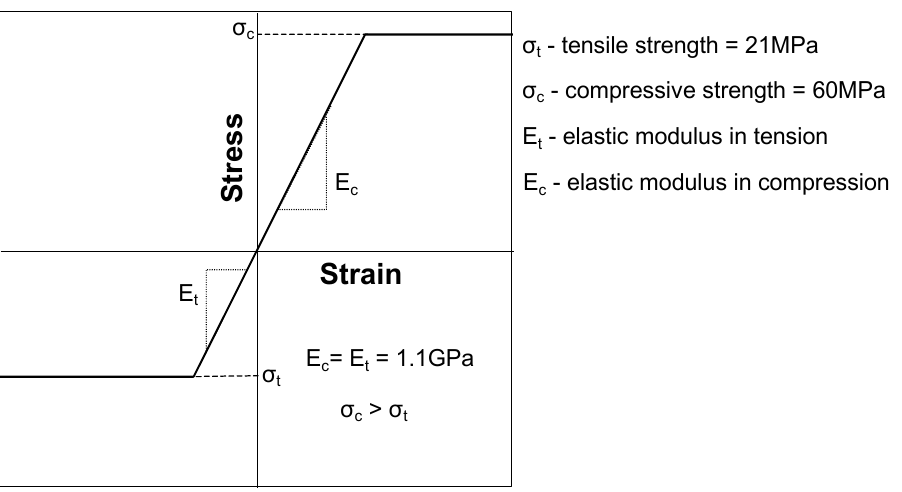
Figure 5. Elastic rigid-plastic stress-strain relationships for the adhesive in tension and compression.